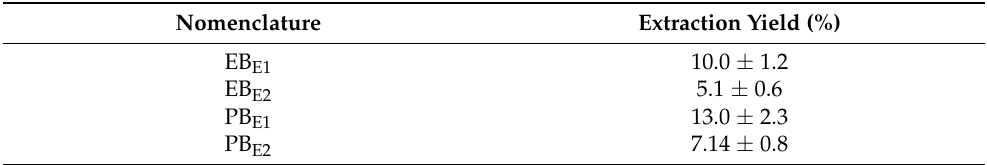
Table 2. Extraction yield for different extraction conditions.